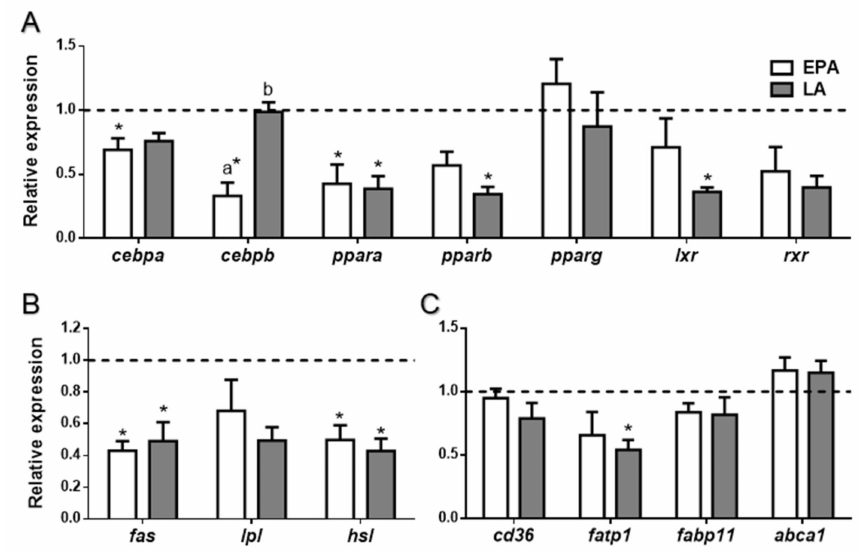
Figure 5. Relative gene expression of ( A ) transcription factors, ( B ) enzymes, and ( C ) lipid transporters in liver of rainbow trout at 6 h after being forced-fed with EPA, LA, or vehicle without fatty acid as control (dashed line). Data are shown as mean + SEM ( n = 6–8). Significant di ff erences ( p < 0.05) with the control are indicated by asterisks (*) and among treatments by di ff erent letters (a,b). EPA: eicosapentaenoic acid; LA: linoleic